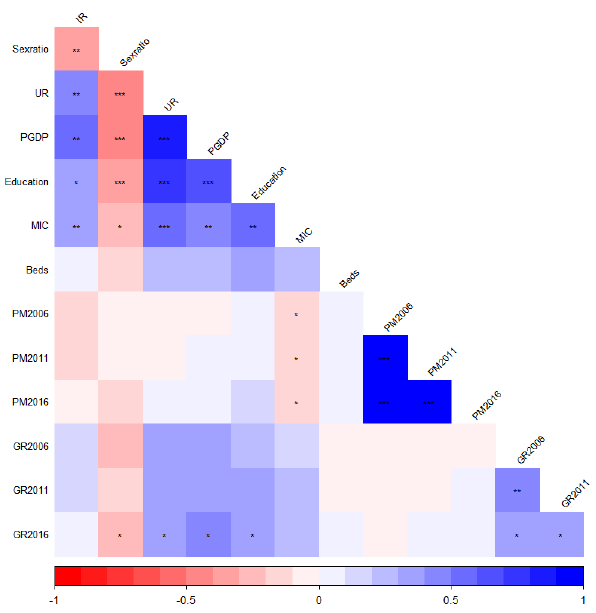
Figure 4. Heatmap of associations between socioeconomic factors and TC incidence. Note: PM (PM 2.5 ), p < 0.05 *, p < 0.01 **, p < 0.001 ***.